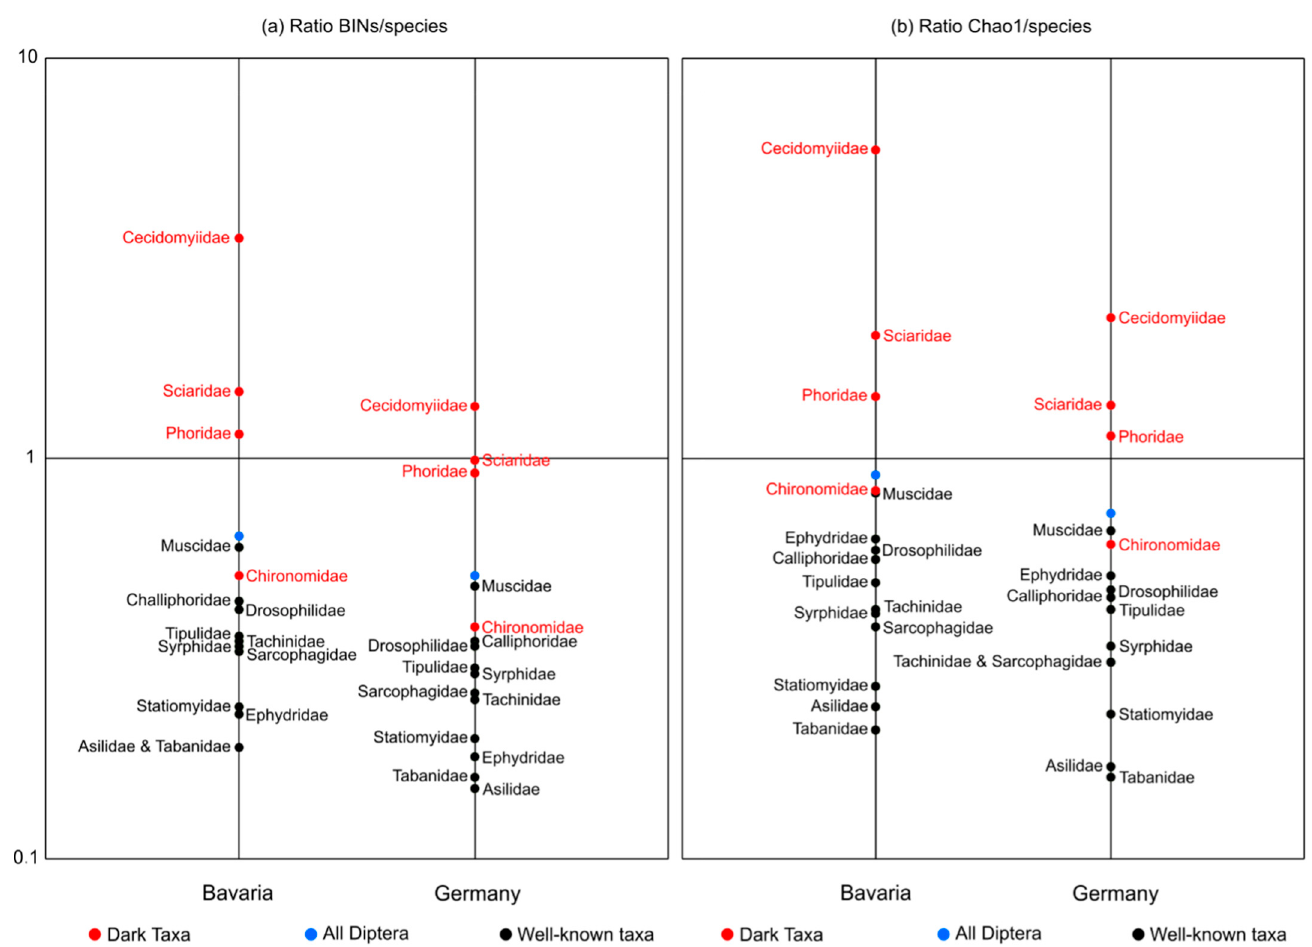
Figure A1. Ratio of BIN or Chao1 counts versus recorded species counts ratios for each family on a logarithmic scale. ( a ) BINs/species and ( b ) Chao1/species for well-known families, problematic families, and for all Diptera for Bavaria and Germany.